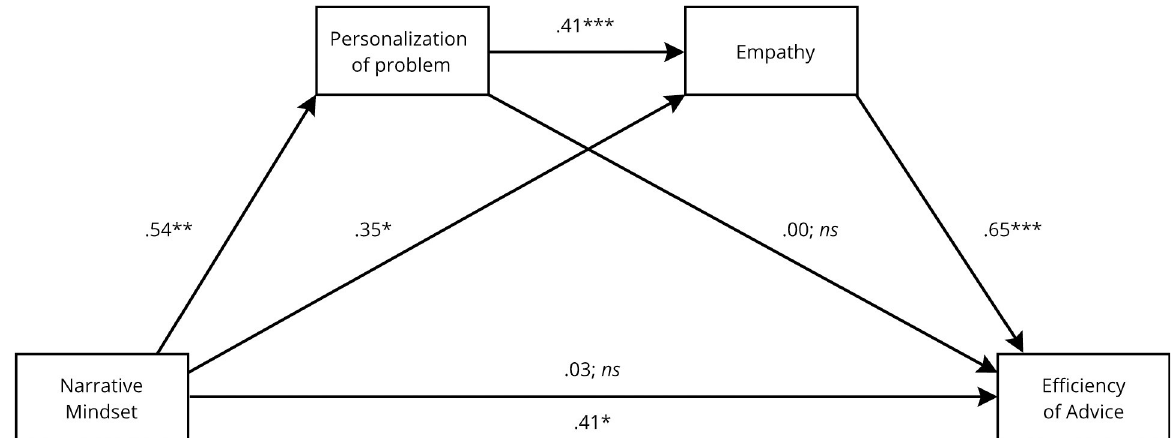
Fig 2. Mediating effect of personalization of problem and empathy on the association between narrative mindset and effectivity of advice– dual-mediation model (the interpersonal problem-solving study). Note : Presented regression coefficients were partially standardized for the narrative mindset predictor. The remaining were fully standardized. Coding for the independent variable: 0 –control, 1 –experimental. � p < .05. �� p < .01. ��� p < .001.